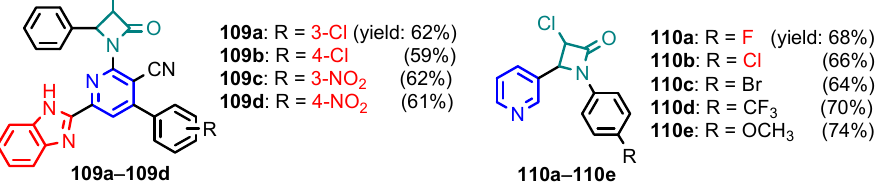
Figure 10. Structure of benzimidazole-pyridine 109a – 109d and 110a – 110e [49,50].